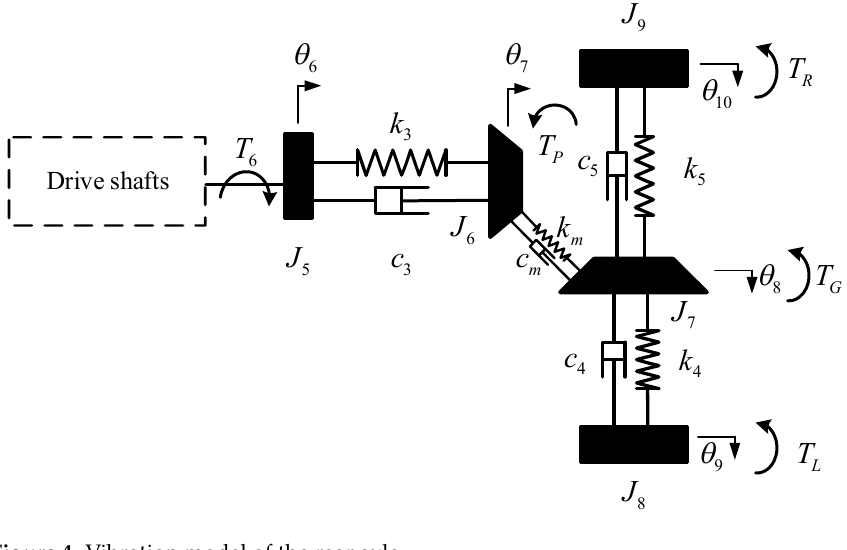
Figure 4. Vibration model of the rear axle.